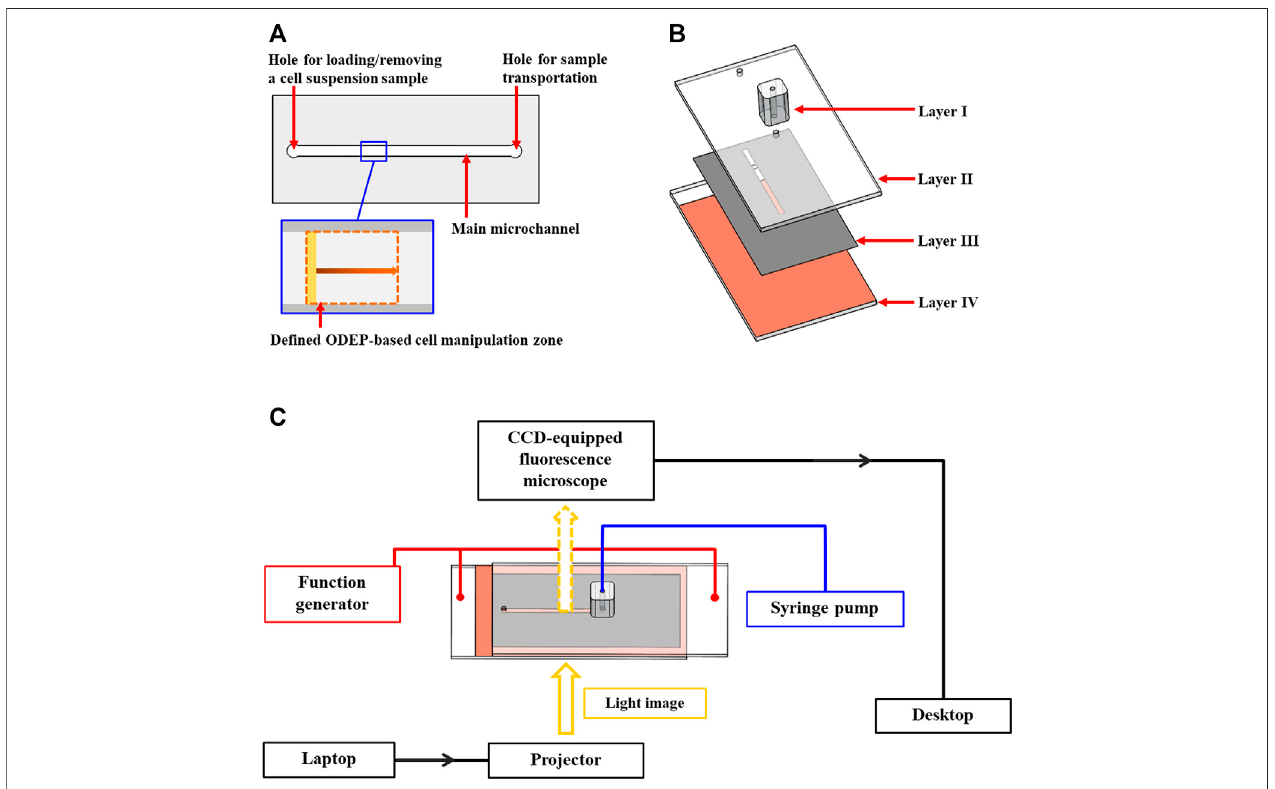
FIGURE 1 | Schematic presentation of the (A) top-view layout and (B) structure of the ODEP micro fl uidic chip (Layer I, PDMS connector; Layer II, ITO glass; Layer III, double-sided adhesive tape with a fabricated microchannel; Layer IV, ITO glass coating with a photoconductive material, and (C) overall experimental setup.